Question: Provide a one-line summary of what is displayed.
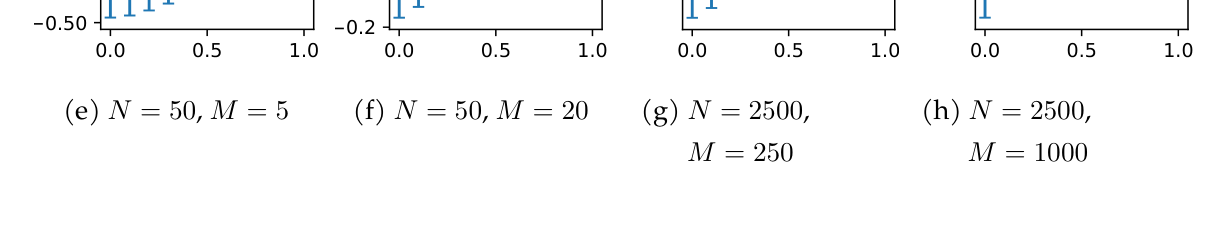
Answer: 1: Prioritising four projects (the fruits) according to their value (x-axes). The semi- opaque icons represent the projects’ true value, and the solid icons represent possible project value estimates under some level of uncertainty (horizontal lines) in the estimation process. (Top) Under a noisy estimation process, projects with a low true value (e.g., project apple) may appear to have a high value and be prioritised erroneously. (Bottom) DEM reduces the estimation noise, enabling a better prioritisation with value estimates closer to the truth. The figures include icons designed by Smashicons from Flaticon.com.